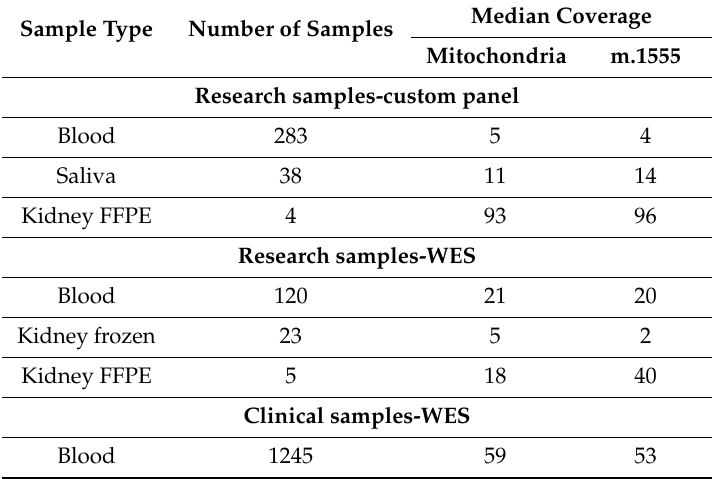
Table 1. Summary of samples and coverage for mtDNA and the m.1555